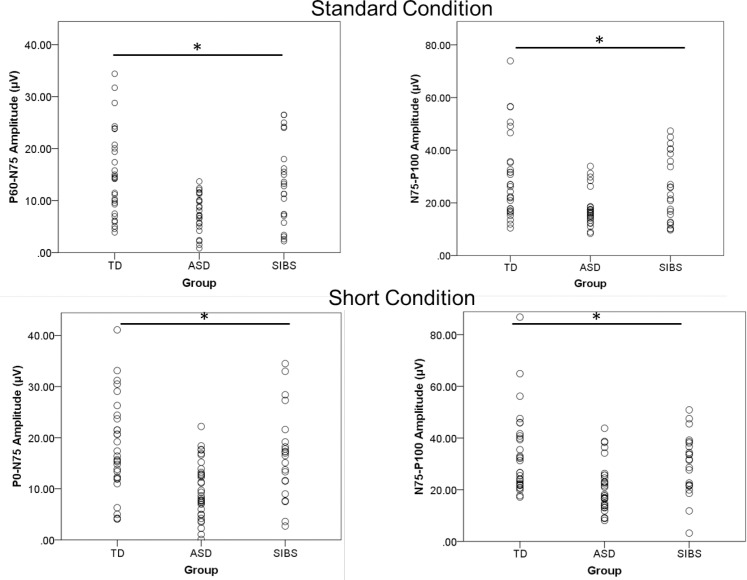
Amplitude by Individual.Scatterplots depict individual amplitude values by group for the standard and short-duration condition. Significance bars indicate p-values < .05.